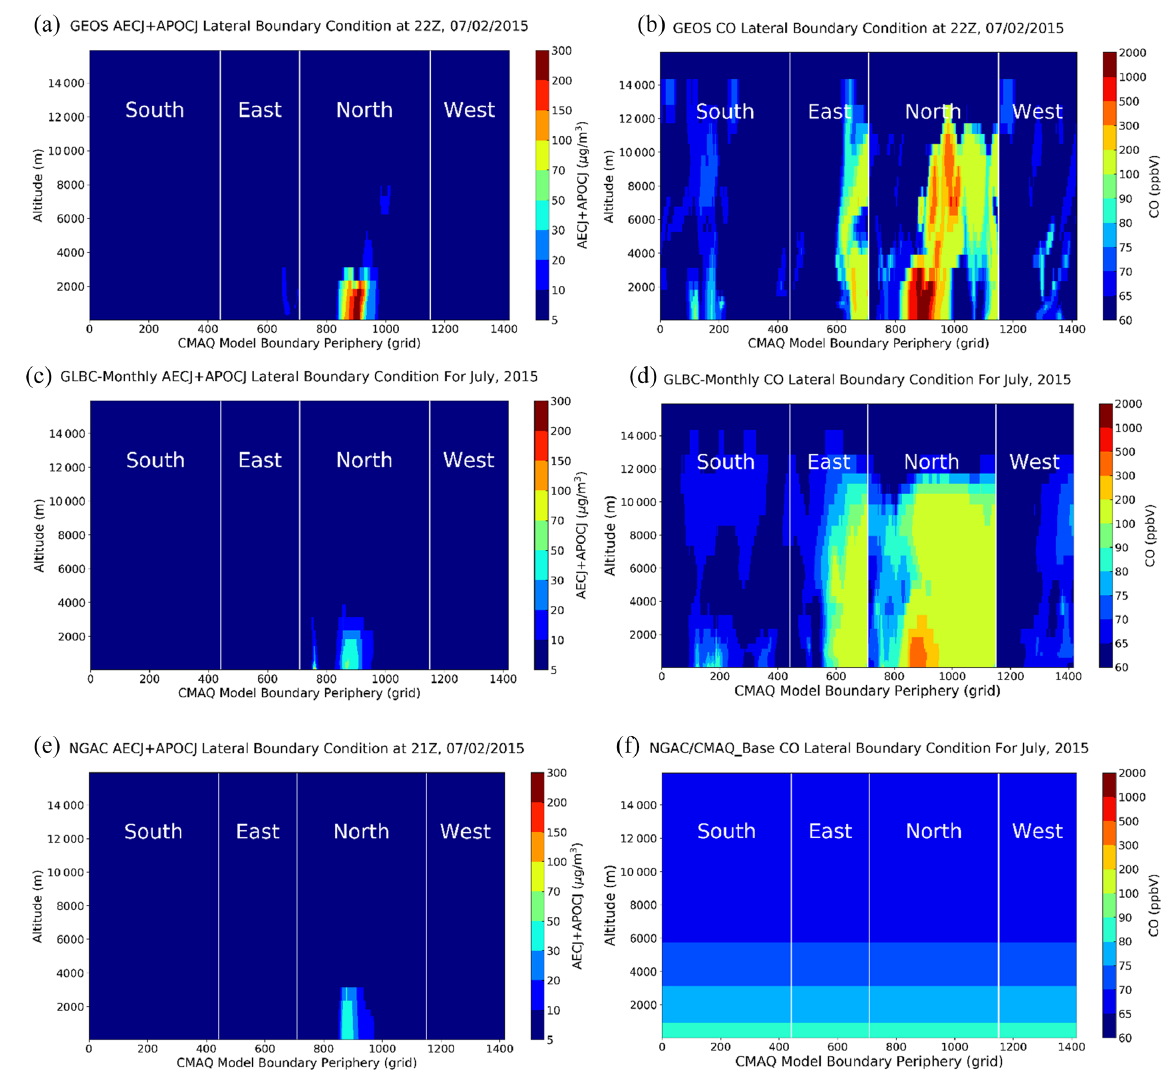
Figure 7. Same as Fig. 3 except for total EC and POC (AECJ + APOCJ) (a, c, e) and CO (b, d, f) . Please note that the dates in this figure are given in the format of month day year